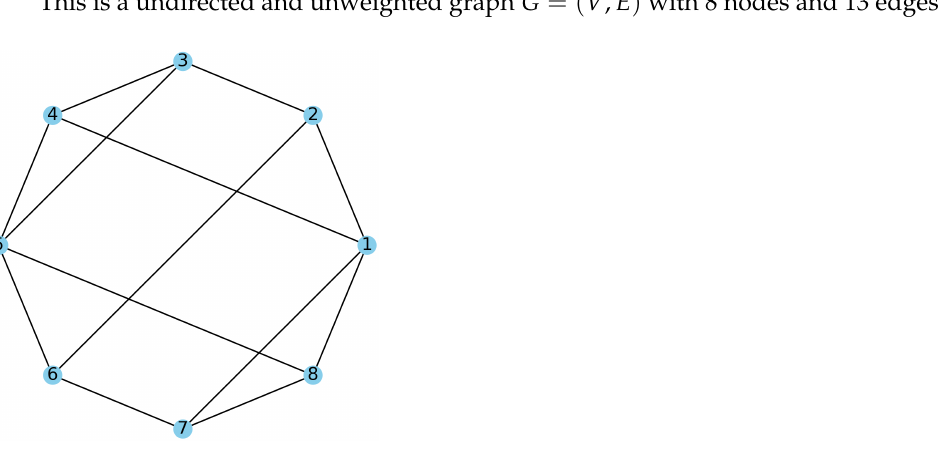
Figure A1. Example figure of undirected and unweighted graph G = ( V , E ) with 8 nodes and 13 edges. The diameter of the graph is